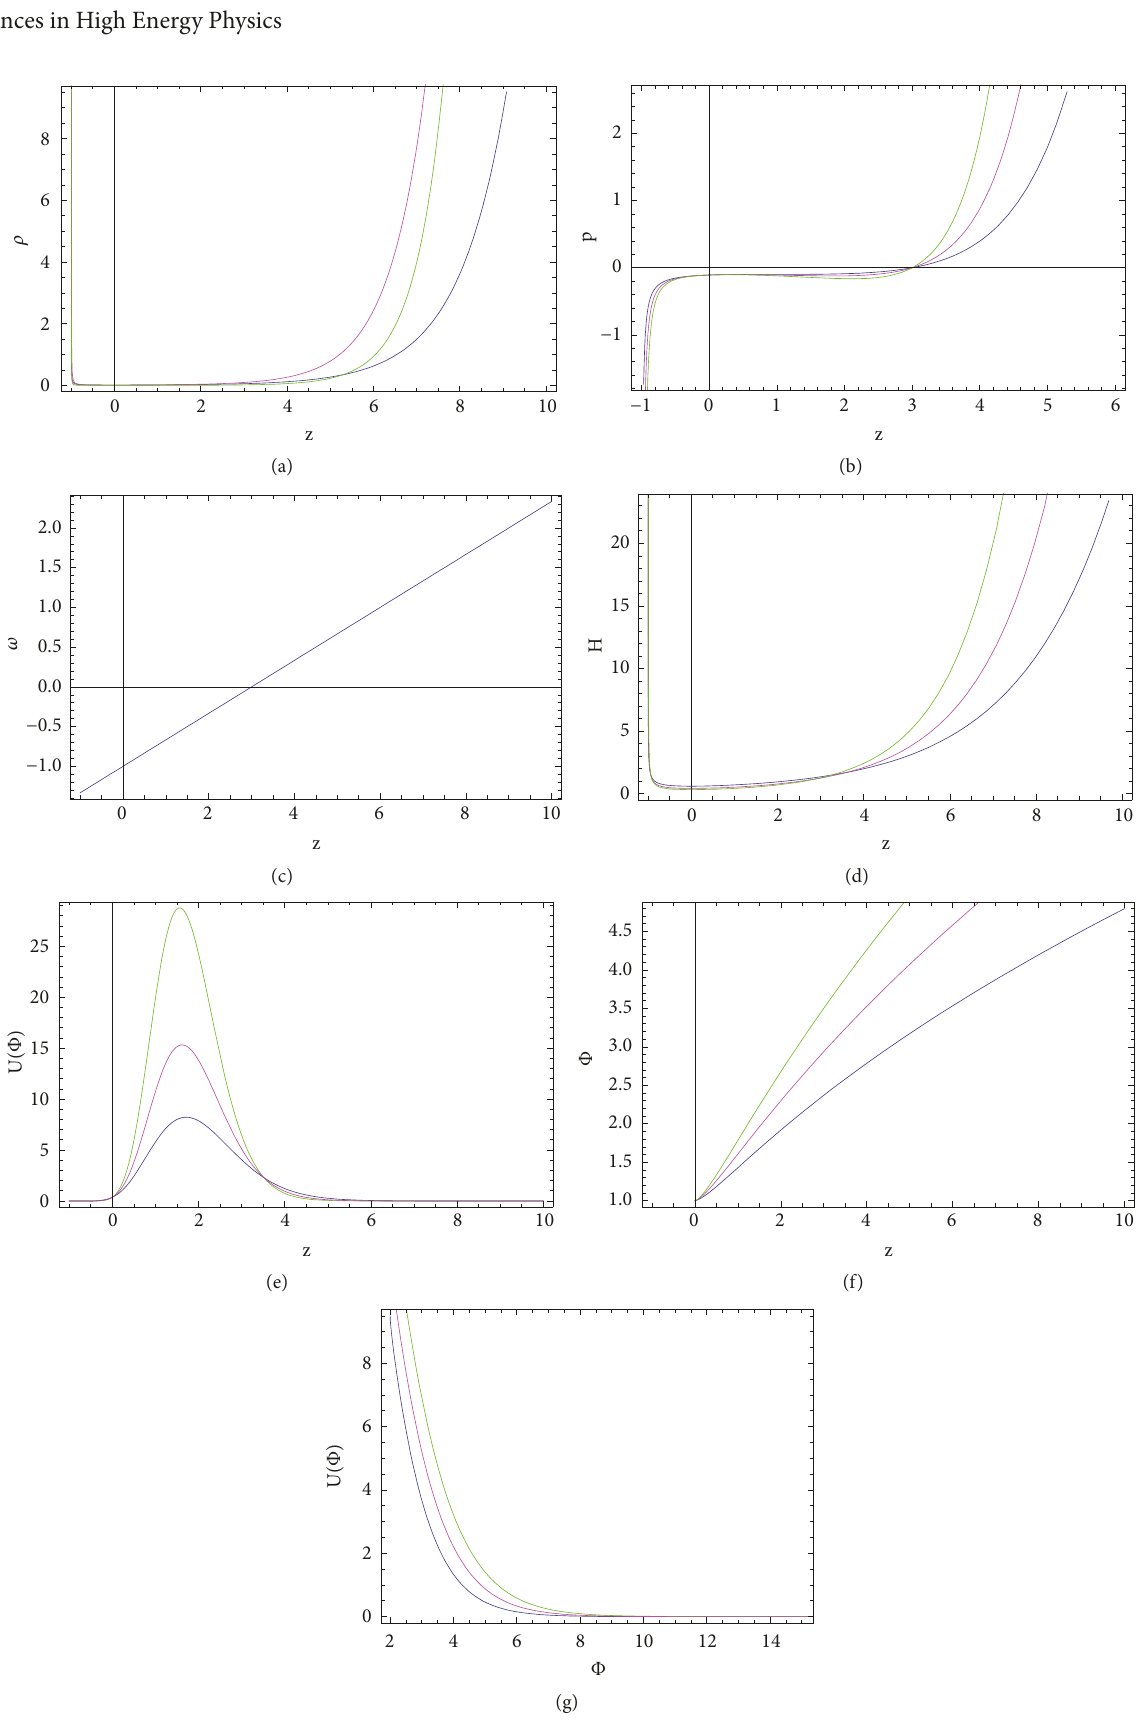
Figure 1: (a), (b), (c), (d), (e), and (f) show the variation of energy density 𝜌 , pressure 𝑝 , EoS parameter 𝜔(𝑧) , Hubble parameter 𝐻 , potential 𝑈(𝜙) , and the scalar field 𝜙 with the variation in 𝑧 for the Linear parameterizations. (g) shows the variation of 𝑈(𝜙) with 𝜙 . Different colored paths are obtained for different values of